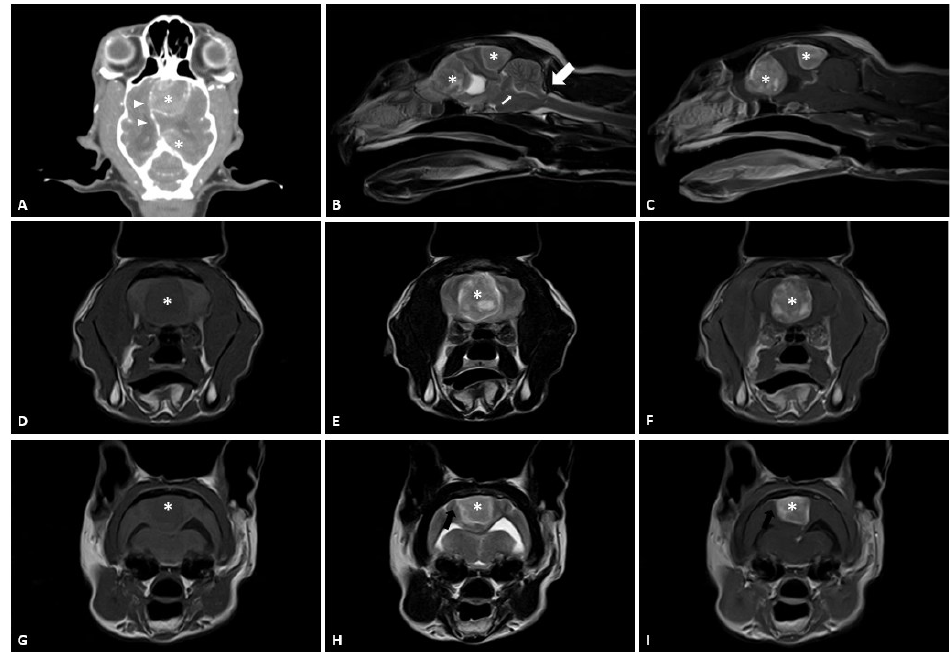
Figure 1. Preoperative post-contrast computed tomography (CT) and magnetic resonance images (MRI) of the head and cervical area. ( A ) Dorsal post-contrast CT images. Contrast-enhanced space-occupying lesions (star) are observed. A brain midline shift (arrowhead) was identified. ( B ) Midline sagittal T2-weighted (T2W) images. Hyperintense space-occupying lesion (star) creates transtentorial herniation (small arrow) and cerebellar herniation (large arrow). ( C ) Midline sagittal T1-weighted (T1W) post-contrast images. Strongly contrast-enhanced heterogenous space-occupying lesions (star) are observed. ( D , G ) Transverse T1W images at the frontal and occipital lobe. Hypointense space-occupying lesions (star) are observed. ( E , H ) Transverse T2W images at the frontal and occipital lobe. Hyperintense space-occupying lesions (star) are observed. ( F , I ) Transverse T1W post-contrast images at frontal and occipital lobe. Strongly contrast-enhanced heterogenous space-occupying lesions (star) are observed. The dural tail sign (black arrow) is identified adjacent to the mass at the occipital